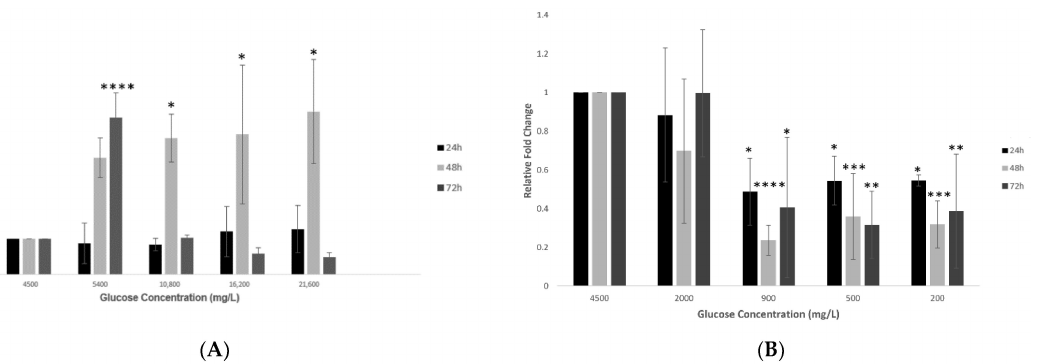
Figure 4. Gene expression of TMPRSS2 in hypothalamic neurons under various glucose concentra- tions at different time points. ( A ) Increase in glucose concentrations (mg/L) of 5400, 10,800, 16,200, and 21,600 at 24, 48 and 72 h time points showed that TMPRSS2 expression increased slightly at 24 h and significantly after 48 h but decreased after 72 h, as compared to the control condition (4500 mg/L). ( B ) With decreasing glucose concentrations (mg/L) of 2000, 900, 500, and 200, at the lowest concentrations of 900, 500, and 200 mg/L, TMPRSS2 expression was observed to decrease significantly compared to the control condition (4500 mg/L). Data is represented as mean ± SEM